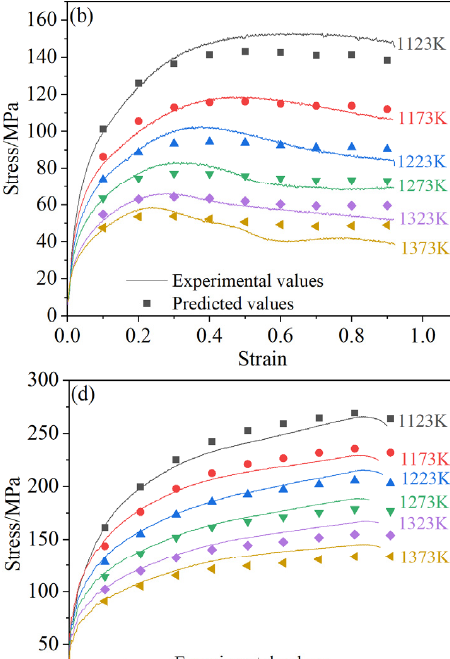
Figure 9. Relationships between material parameters and ε : ( a ) α ; ( b ) n ; ( c ) Q ; ( d ) ln A .